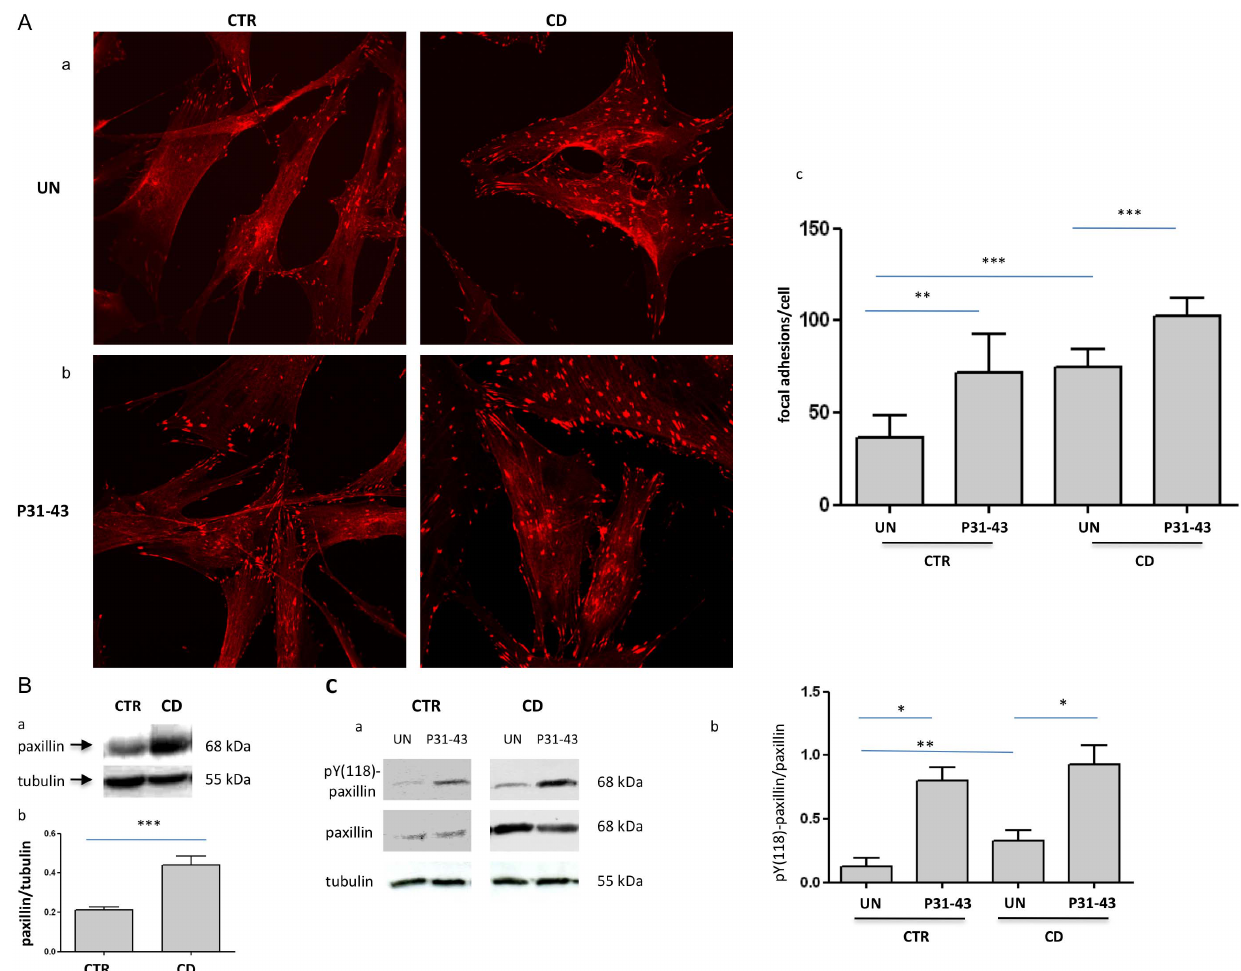
Figure 2. Analysis of the focal adhesion number and paxillin protein levels in CD and controls fibroblasts before and after P31-43 treatment. A. Increase of the focal adhesion number in CD, as revealed through paxillin staining before and after P31-43 treatment. a) Confocal immunofluorescence images of fibroblasts from CD patients and controls stained with antibodies against paxillin. Representative fields. b) Confocal immunofluorescence images of fibroblasts stained with antibodies against paxillin from CD patients and controls treated with P31-43 for 30 min. Representative fields. c) Statistical analysis of the number of paxillin-positive focal adhesions per cell before and after P31-43 treatment. Focal adhesions of 30 fibroblasts of several fields from 3 independent experiments from 6 patients and 6 controls were counted. Columns represent the means, and the bars represent the standard deviations. Student’s t -test. **= p , 0.01; ***= p , 0.001. B. Paxillin protein levels are increased in fibroblasts from CD patients with respect to controls. a) Western blot analysis of fibroblast protein lysates from controls and CD patients. The upper line is stained for paxillin, and the lower line is stained for tubulin. Representative experiment. b) Densitometric analysis of western blots stained for paxillin in fibroblasts from 6 CD patients and 6 controls. Paxillin levels were normalized to the tubulin levels. Columns represent the means, and the bars represent the standard deviation. Student’s t -test. ***= p , 0.001. C. Paxillin phopshorylation is increased in CD fibroblasts and is further increased after P31-43 treatment for 30 9 . a) Western blot analysis of fibroblast protein lysates from controls and CD patients. The upper line is stained for pY-paxillin, the middle line is stained for paxillin, and the lower line is stained for tubulin. Representative experiment. b) Densitometric analysis of western blots stained for pY-paxillin and paxillin in fibroblasts from 5 CD patients and 5 controls. pY-paxillin levels were normalized to the paxillin levels. Columns represent the means, and the bars represent the standard deviation. Student’s t -test. *= p , 0.05; **= p , 0.01.